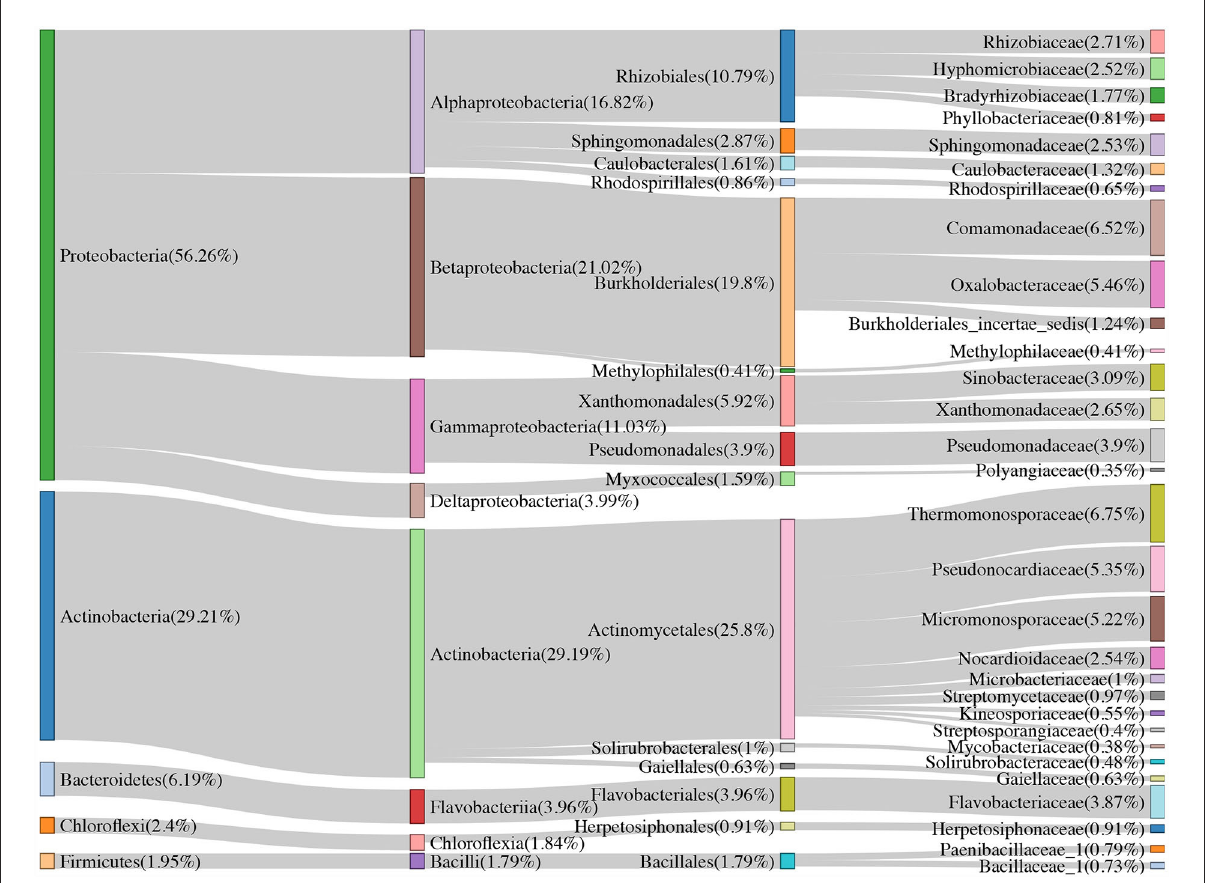
FIGURE2 The community composition of Moso bamboo rhizome root microbiota and soil bacteria with their relative abundance list on the right.